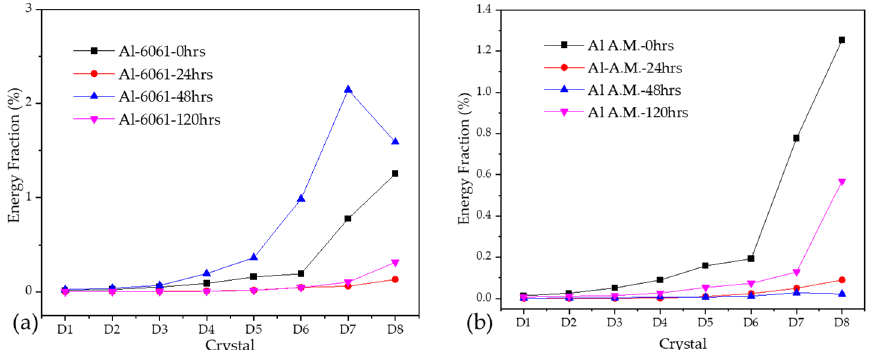
Figure 13. Wavelets in NaCl solution ( a ) Al-6061 and ( b ) Al-A.M.